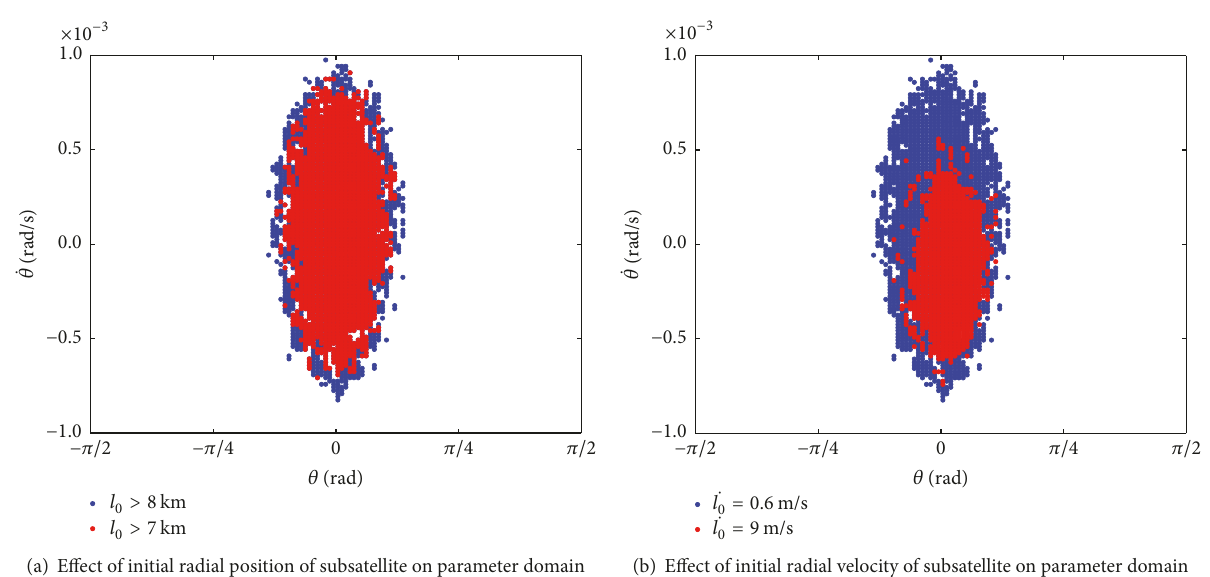
(b) Effect of initial radial velocity of subsatellite on parameter domain Figure 16: Dependence of parameter domain in the range 𝜃 ∈ [−𝜋/6, 𝜋/6] .